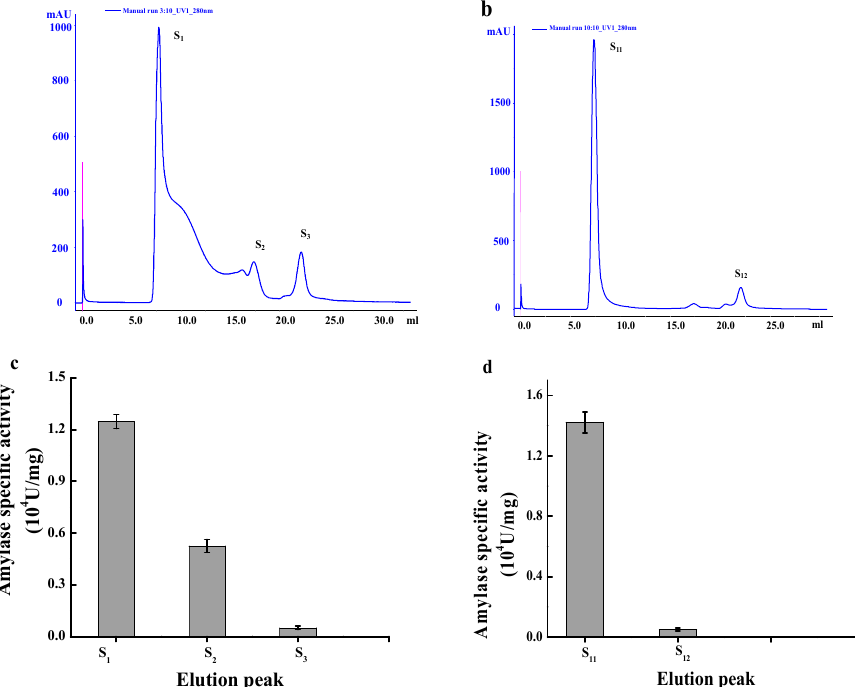
Figure 7. Separation curve of Mal-mPEG5000-SPA by gel column Superdex TM 75 ( a )Elution profile of Mal-mPEG5000-SPA by Superdex TM 75 for the first time; ( b ) Elution profile of Mal-mPEG5000-SPA by Superdex TM 75 for the second time; ( c ) The specific activity of the elution fractions from Superdex TM 75 for the first time; ( d ) The specific activity of the elution fractions from Superdex TM 75 for the second time.